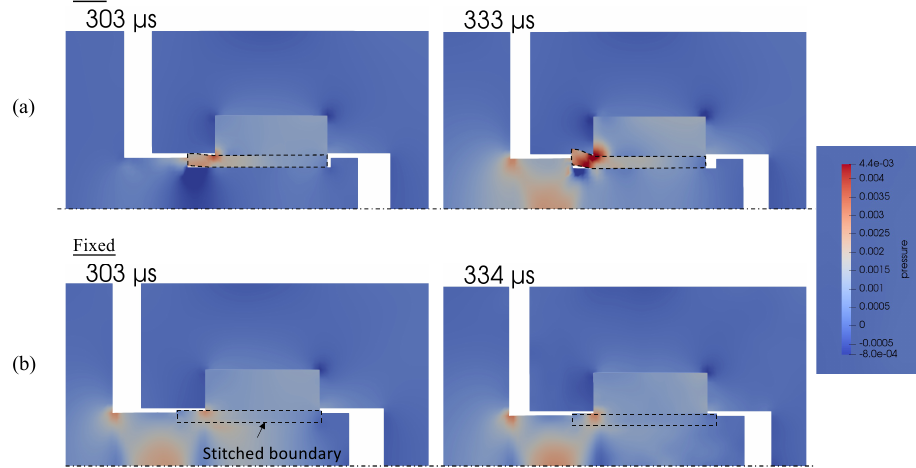
Fig. 3. Sample behaviour associated with a (a) free and (b) fixed sample/rod interface for friction conditions µ k = µ s = 0.6 and a normal applied pressure of 100 MPa. The illustrated pressure scale is represented in